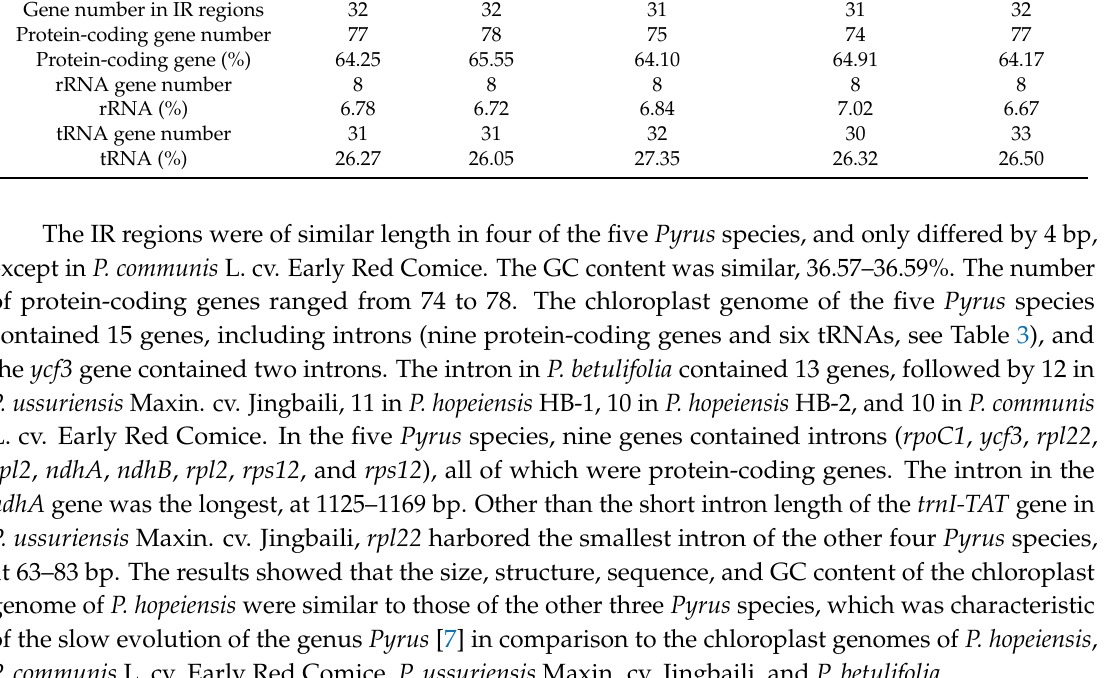
Pyrus ussuriensis Pyrus Pyrus hopeiensis hopeiensis Maxin. cv. HB-2 HB-1